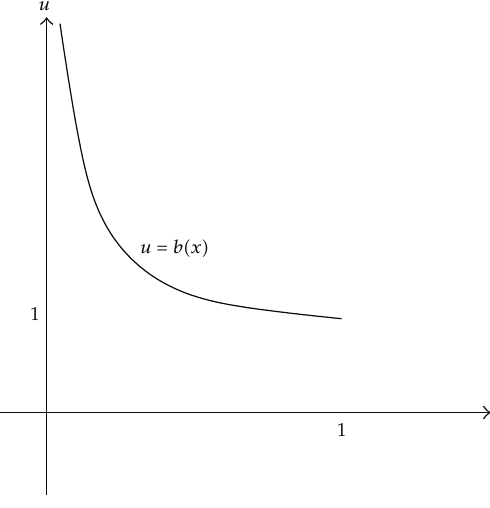
Figure 1: Graph of b for Example